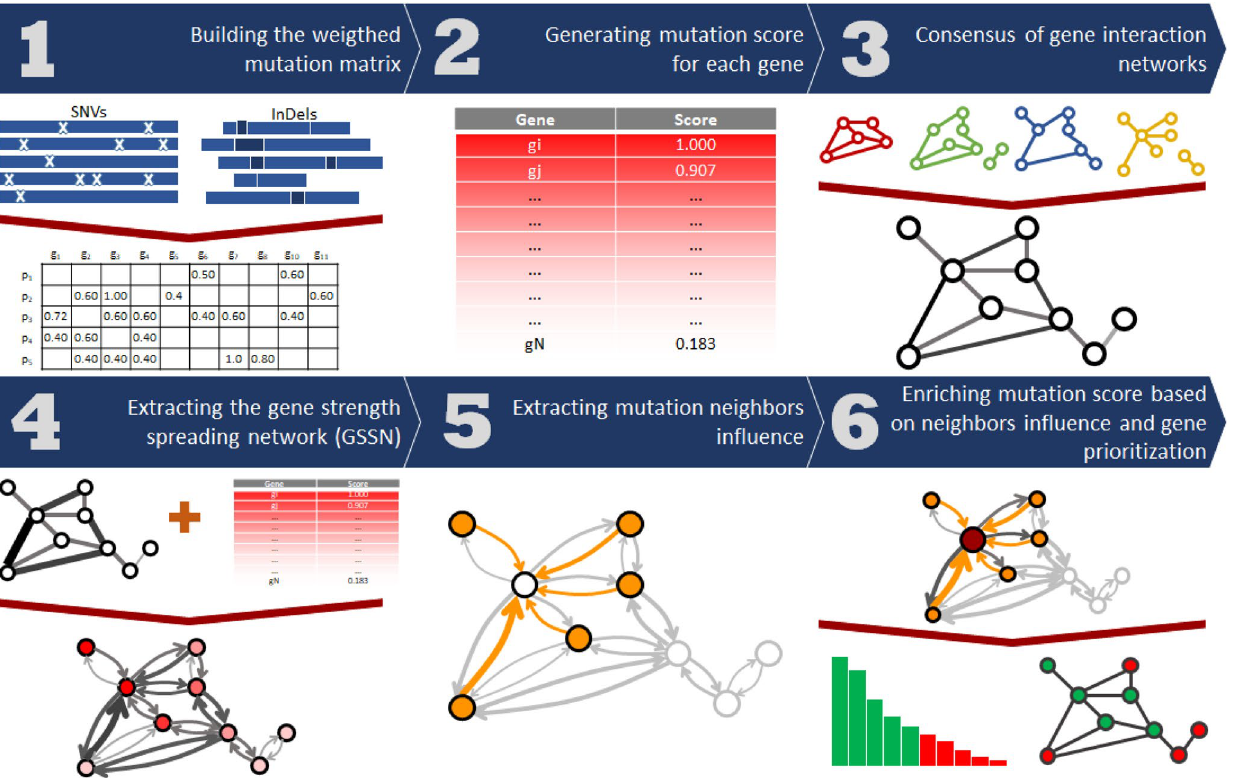
Figure 1. DiSCaGe